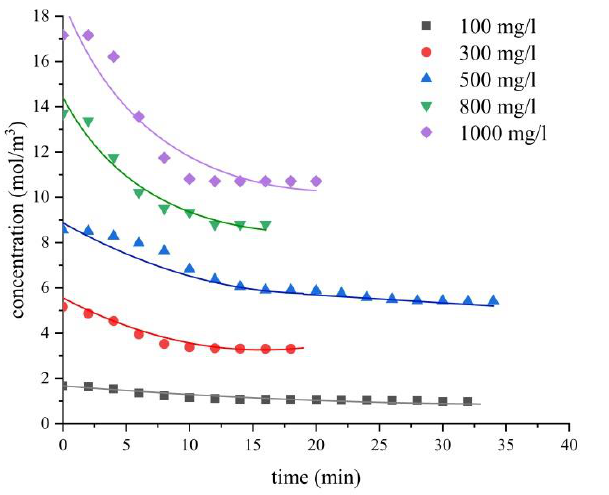
Figure 9. Salt concentration vs. time in batch-mode CDI experiment. Lines: theory; dots: experimental data.